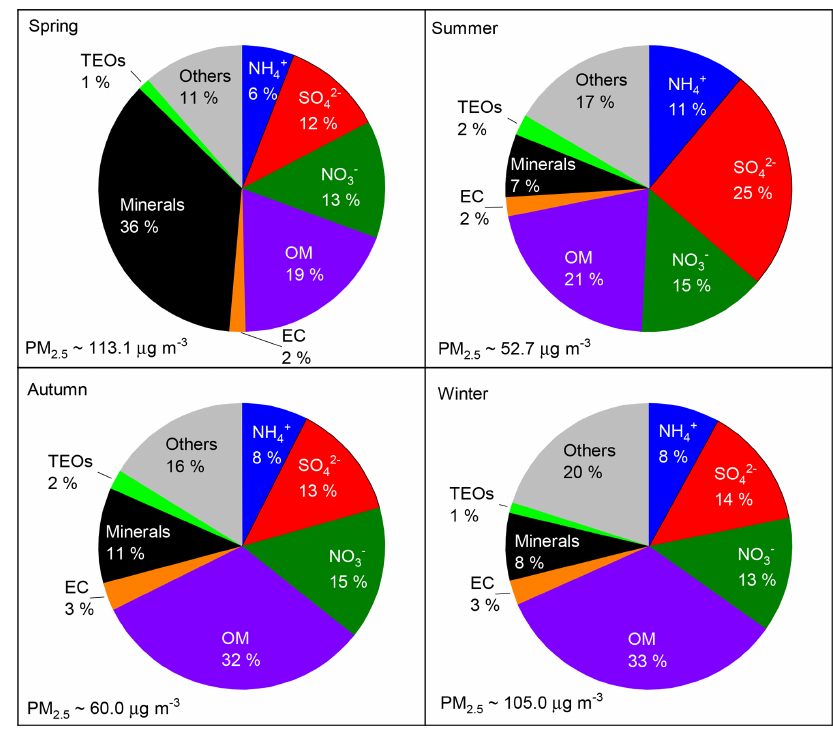
Figure 4. Seasonal variations in PM 2 . 5 and its eight major components from 1 March 2012 to 28 February 2013.